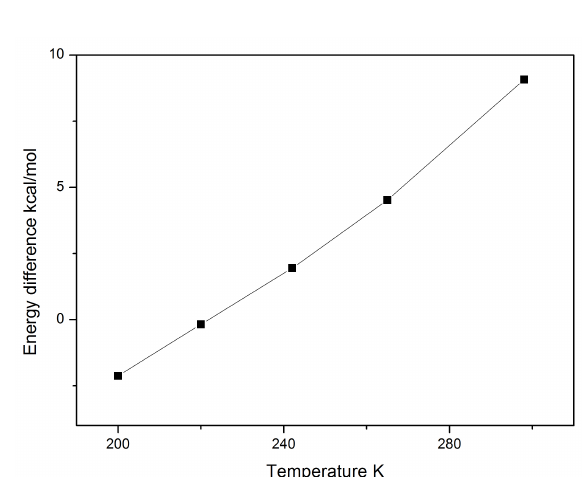
Figure 3. Free energy difference between three and four sulfuric acid ionic clusters, for 220K and 200K points we used the same concentrations as given for Δ G 1 in Table 3